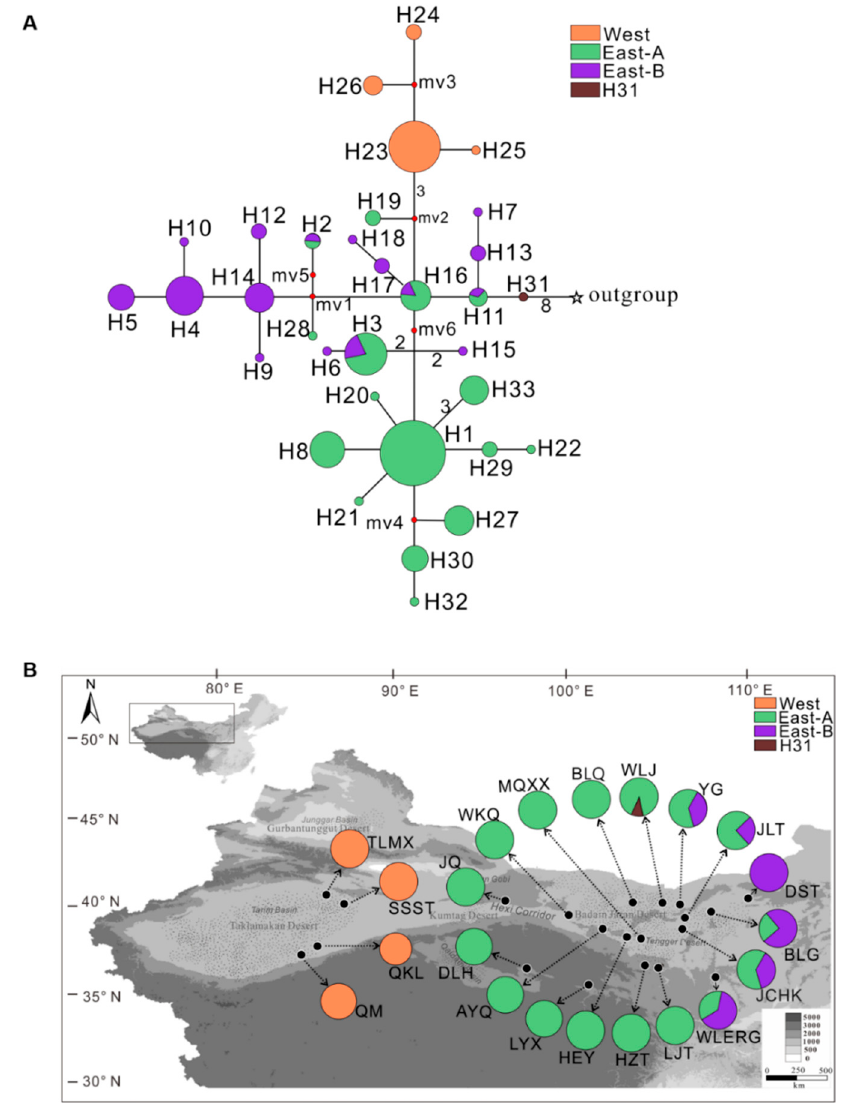
Figure 2. Phylogenetic topology and geographical distribution of Nitraria tangutorum chloroplast DNA (cpDNA) haplotypes. ( A ) Haplotype topology built using median-joining approach. P ie size is proportional to haplotype frequency, and the red circles from medium vector 1 (mv1) to mv6 indicate missing haplotypes that are not sampled in this study. Different colors of the pie diagrams denote haplotypes from different lineages. ( B ) Geographical distribution of 31 haplotypes detected in N. tangutorum (population codes are presented in the Table 1). Table 1. Geographic and genetic information for the sampled populations of Nitraria tangutorum. s , number of segregating sites; h , number of haplotypes; H d, estimates of haplotype diversity; π , nucleotide diversity within populations.